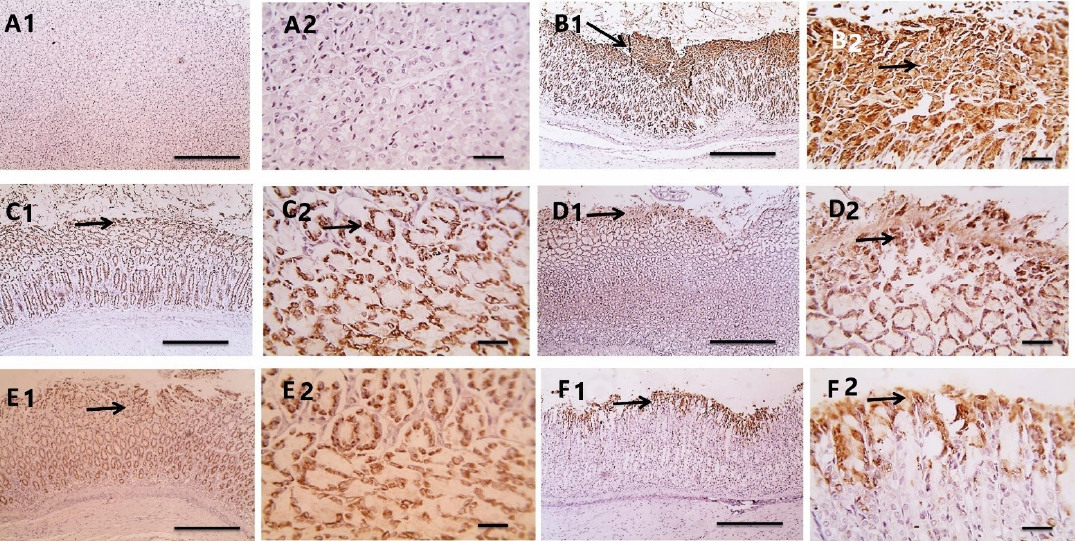
Figure 10. Microscopic pictures of H&E-stained glandular gastric mucosa from H. pylori infected rats treated with PEAME ( A1 , A2 ) showing metaplasia (black arrows) with few mononuclear cells’ infiltration and submucosal edema in some sections. Meanwhile, the glandular gastric mucosa from H. pylori infected rats treated with metronidazole ( B1 , B2 ) showed apoptosis, adenoma with metaplasia (black arrows), necrosis, mononuclear cells infiltration, and submucosal edema. ( C1 , C2 ) the glandular gastric mucosa from H. pylori infected rats taking PEAME prophylactic. ( D1 , D2 ) the glandular gastric mucosa from H. pylori infected rats taking PEAME treatment. ( E1 , E2 ) the glandular gastric mucosa from H. pylori infected rats taking metronidazole. ( F1 , F2 ) the glandular gastric mucosa from H. pylori infected rats taking PEAME and metronidazole. Low magnification X: 100 bar 100 and high magnification X: 400 bar